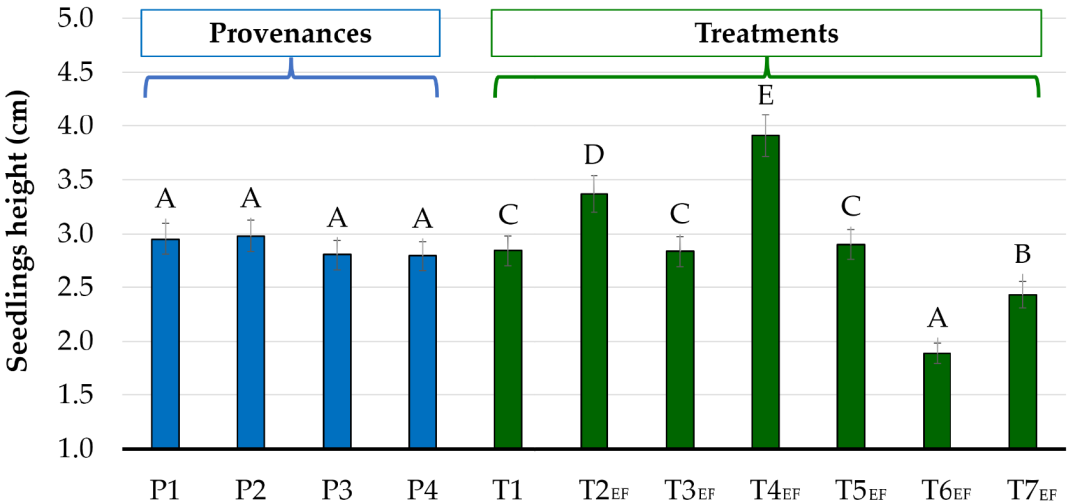
Figure 5. Seedlings’ height (cm), after EF treatments, with regard to seed provenances and treatments (mean ± SE; n = 50). The means represented with blue color reflect the influence of the provenance (P1—M ă ria Mic ă , P2—F ă ina, P3—Alunis , and P4—Putnis oara), regardless of the treatment applied; , , the means represented with green color reflect the influence of the EF treatment (T1 EF (Control), T2 EF (10 V-15 min), T3 EF (10 V-35 min), T4 EF (30 V-15 min), T5 EF (30 V-35 min), T6 EF (50 V-15 min), and T7 EF (50 V-35 min)), regardless of the provenance. Different (upper case) letters at the top of the bars indicate statistically significant differences between provenances, and respectively treatments, according to Duncan’s MRT test ( p <